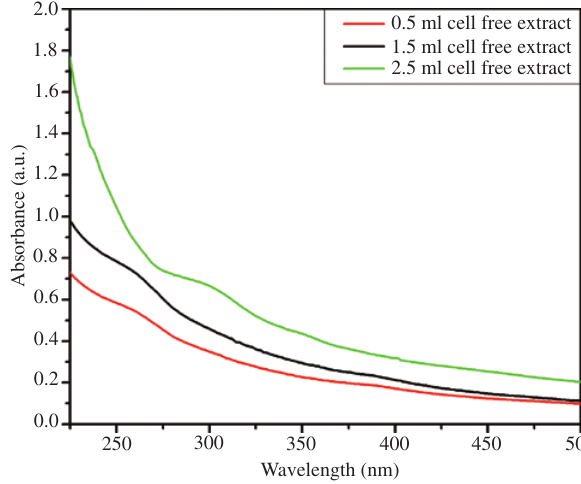
Figure 3: Effect of pH on the synthesis of zinc sulfide nanoparticles using Chlamydomonas reinhardtii .